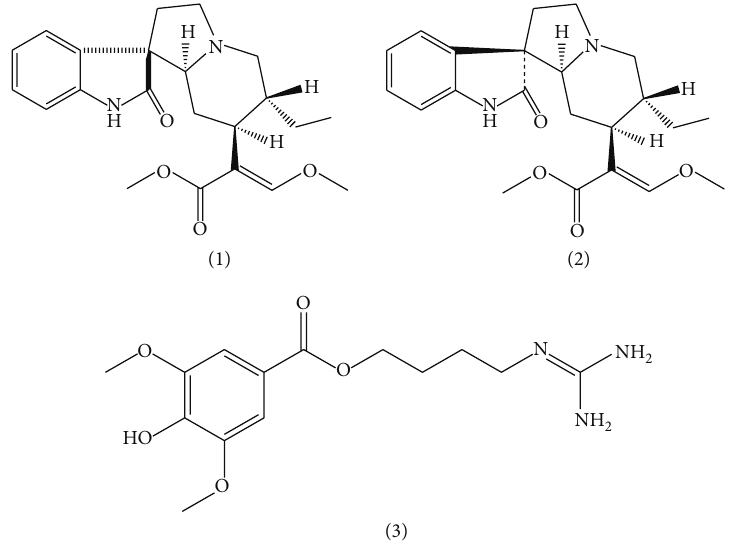
Figure 1: Chemical structure of alkaloids: (1) rhynchophylline; (2) isorhynchophylline; (3)